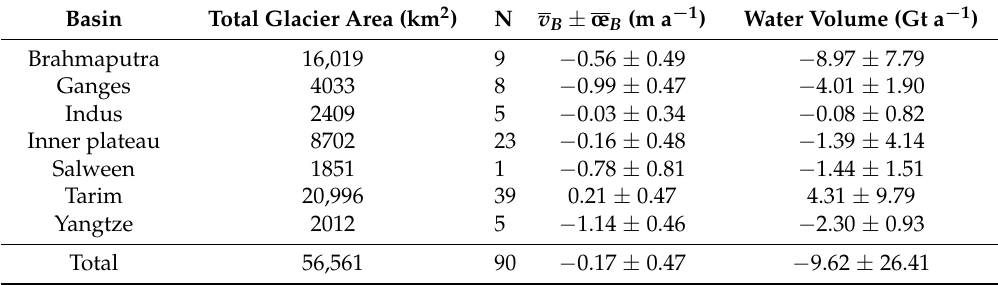
Table 3. Mean glacial thickness change rate per basin, where N is the number of observed glaciated areas and the total glacier area is obtained from the GLIMS glacier mask. Lost or gained water volumes from glaciers are approximately estimated, by multiplying the mean glacial thickness change rate with the total glacier area of each